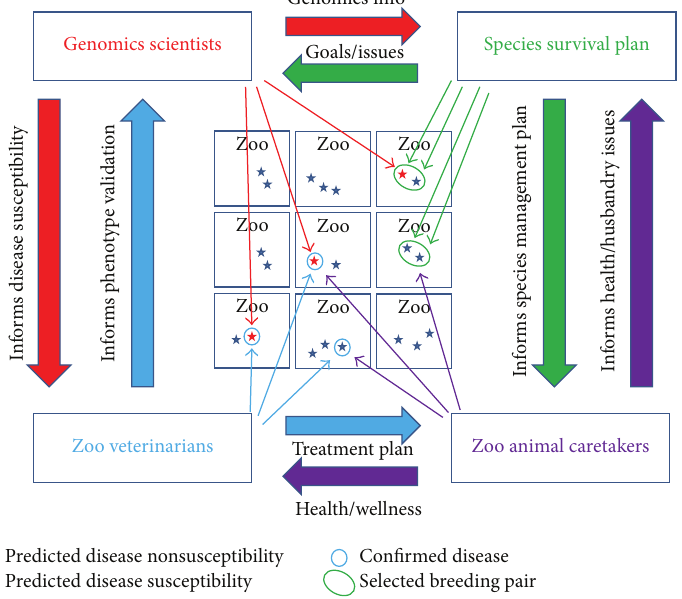
Figure 5: Bidirectional communication validates genomics predictions and enhances management. A communication network consisting of genomics scientists (red), species survival plan members (green), zoo animal caretakers (purple), and zoo veterinarians (blue) is illustrated schematically showing some of the possible communication paths and associated role of stakeholders in the network. Genomics scientists can provide genomics knowledge in which specific members of the endangered captive population are annotated as “ susceptible ” to an undesirable clinically relevant phenotype (red stars). Members of the population that are considered to be less susceptible are shown as well (dark blue stars).Redarrowsoriginatingfromthegenomicsscientistsandpointingatmembersofthecaptivepopulationwithinzoos(redstars)represent the genomic knowledge applied to the captive population. Zoo veterinarians provide clinical assessment of phenotypes (blue circles around either red or dark blue stars) and subsequently validate genomics predictions. Species survival plan members select breeding pairs (green circle surrounding two stars) which can be informed by genomics information. For example, animals that are carriers for autosomal recessive undesirable phenotypes can be bred with partners that do not contain the undesirable allele, thereby allowing maximized genetic diversity while simultaneously minimizing the production of offspring with undesirable phenotypes. Zoo animal caretakers interact with the animals on a daily basis and provide and implement treatment and husbandry plans as well as serving as the eyes and ears for the endangered species. Purple arrows originating from the zoo animal caretakers and pointing to stars represent daily interactions of the zoo staff with the animals in the capacity of health, husbandry, breeding, socialization, and enrichment. The large colored arrows between the four stake holder’s boxes represent examples of the types of bidirectional communication that can occur within the network to maximize the value of all information for the benefit of the endangered captive